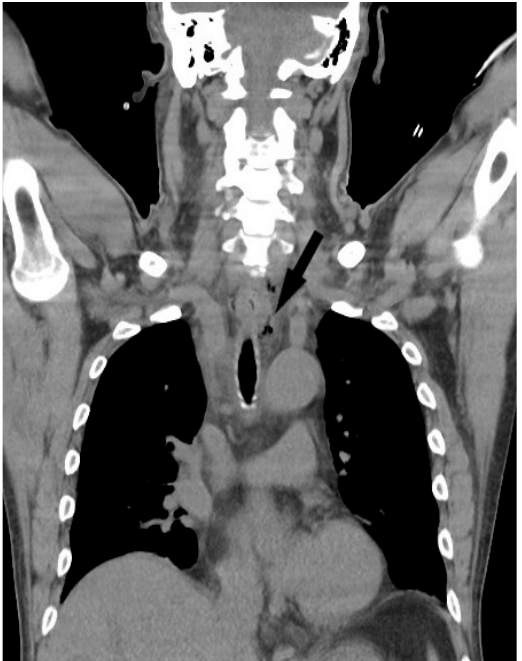
Figure 2. Air-containing abscess (black arrow) extends from deep neck space to the upper medias- tinum.